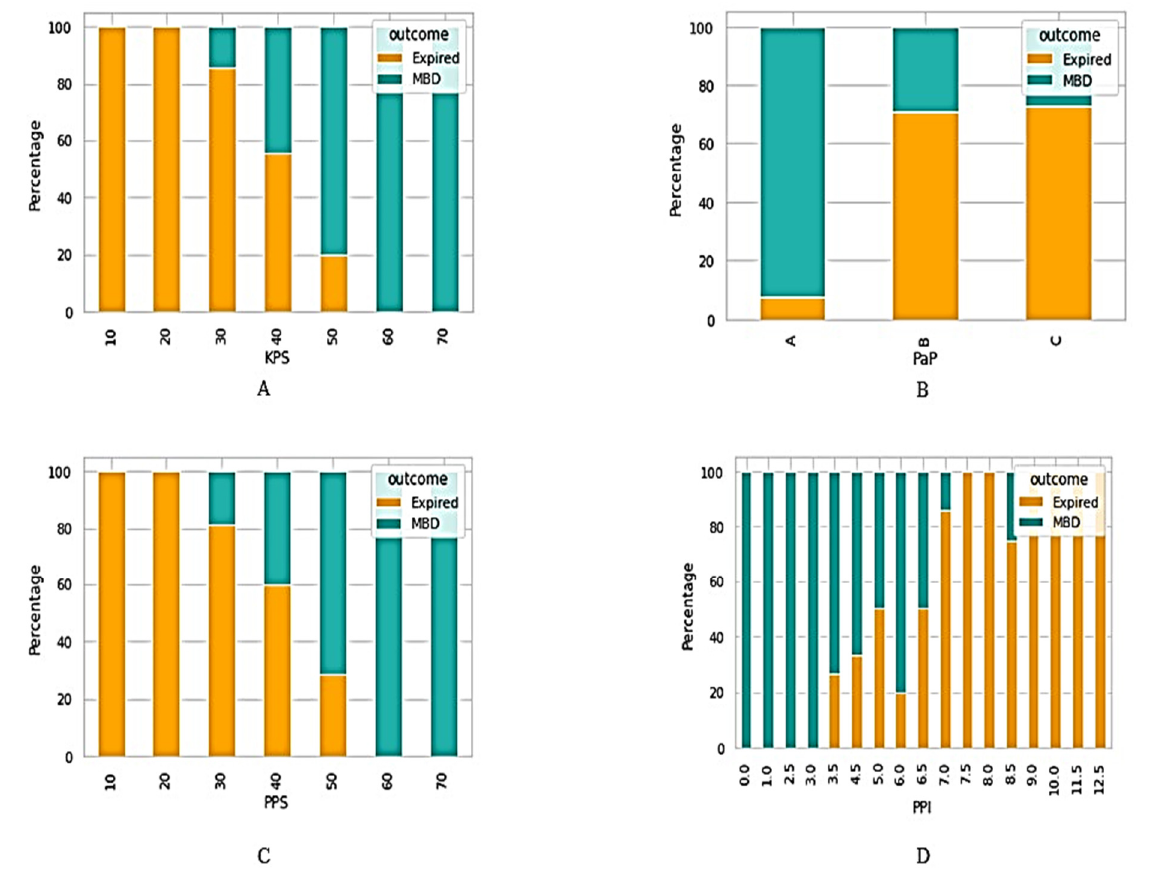
Figure 1. Classification of patients on the basis of prognostic tools. ( A ) KPS: Karnofsky Perfor- mance Status score-based classification; PaP: ( B ) Palliative Prognostic Score based classification; ( C ) PPS: Palliative Performance Scale based classification; ( D ) PPI: Palliative Prognostic Index based classification.